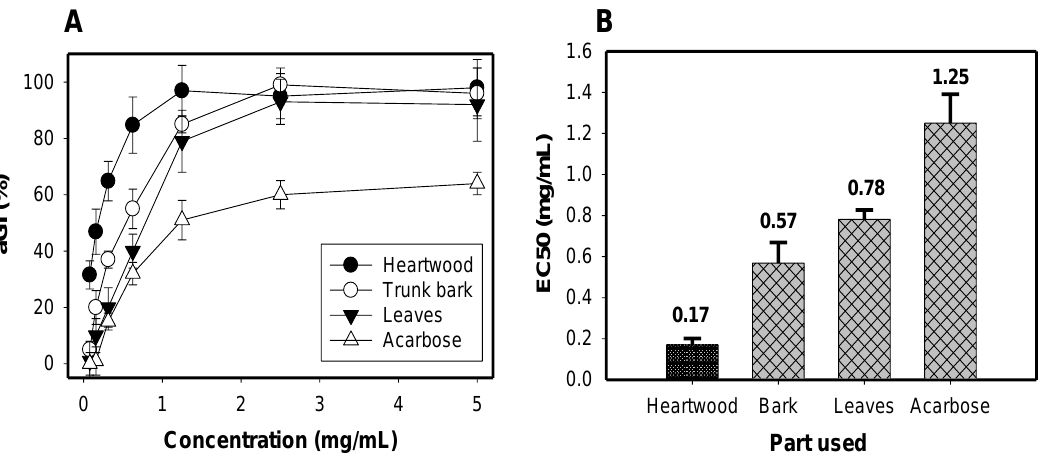
Figure 1. The inhibition of different Dalbergia tonkinensis parts used and expressed as aGI % ( A ) and EC 50 values ( B ); results are means ± SD of multi tests (n = 3).